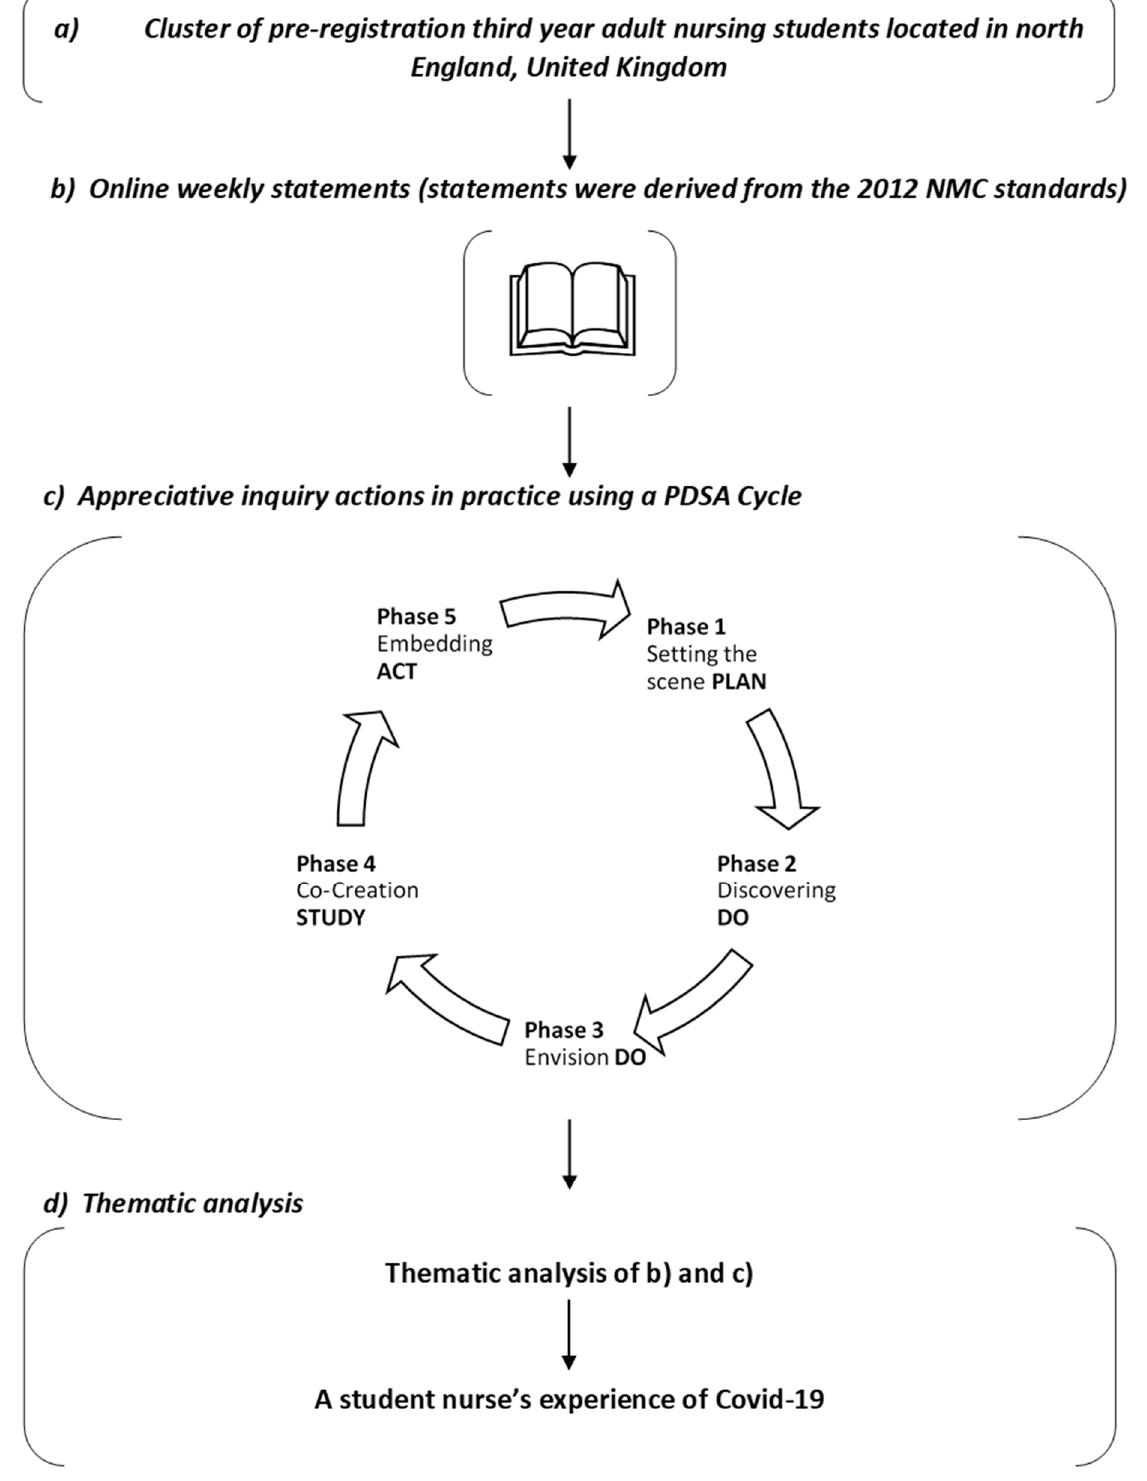
Figure 1. Unpacking a reflective qualitative appreciative inquiry using a service evaluation approach.